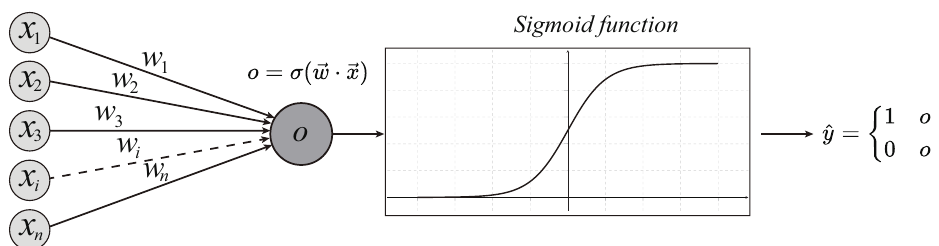
Figure 3. Illustration of logistic